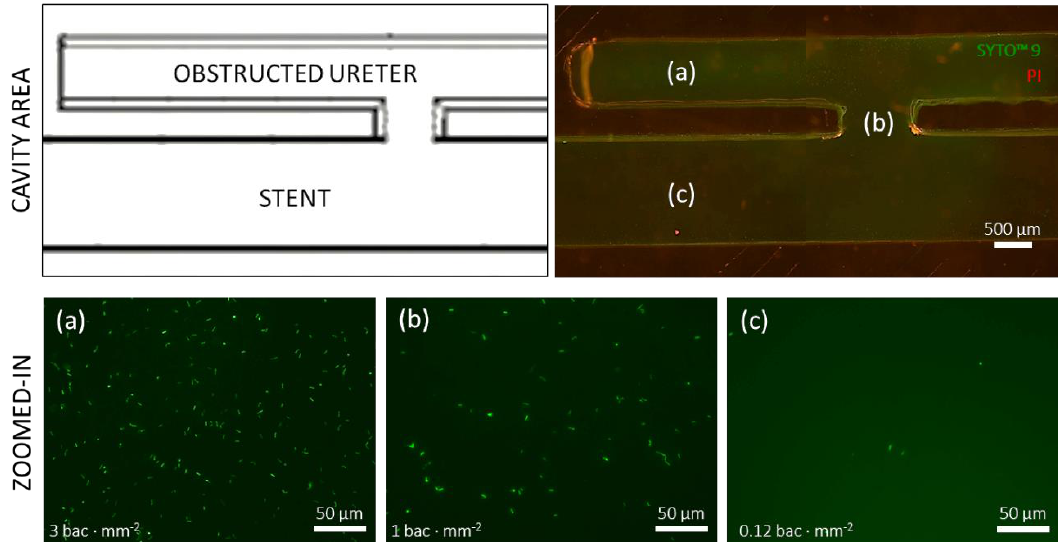
Figure 4. Fluorescence staining by SYTO™ 9 and propidium iodide reveals differences in the number density of bacteria adhered over different regions of interest in the obstructed I device. (Top) Close up schematic of cavity area and overview fluorescence image of SYTO™ 9 (green) and propidium iodide (PI; red). (Bottom) Fluorescence micrographs were obtained to quantify the number density of bacteria in ( a ) the cavity region (average of 238 ± 7 bacteria in the field of view), ( b ) the proximal side-hole (average of 80 ± 10 bacteria in the field of view), and ( c ) a region of the stent lumen close to the inlet (average of 10 ± 4 bacteria in the field of view). All images were acquired in the same focal plane (top surface of the glass coverslip).